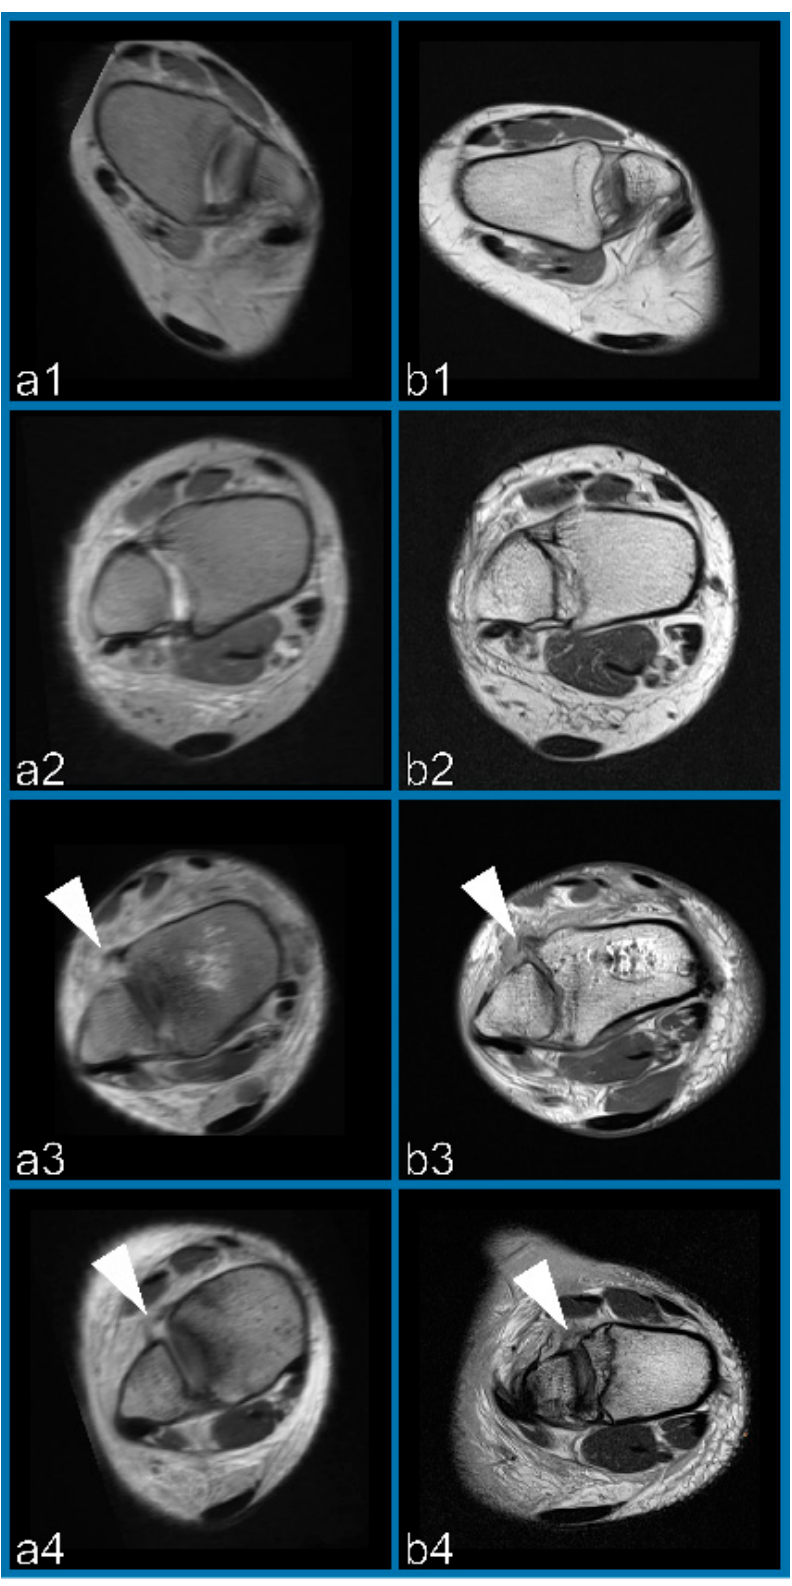
Figure 2. Example of two patients with intact ( 1 , 2 ) and ruptured ( 3 , 4 ) anteroinferior tibiofibular ligament (AITFL) in the OFR ( a ) and scanned ( b ) images. Arrowheads show the rupture.